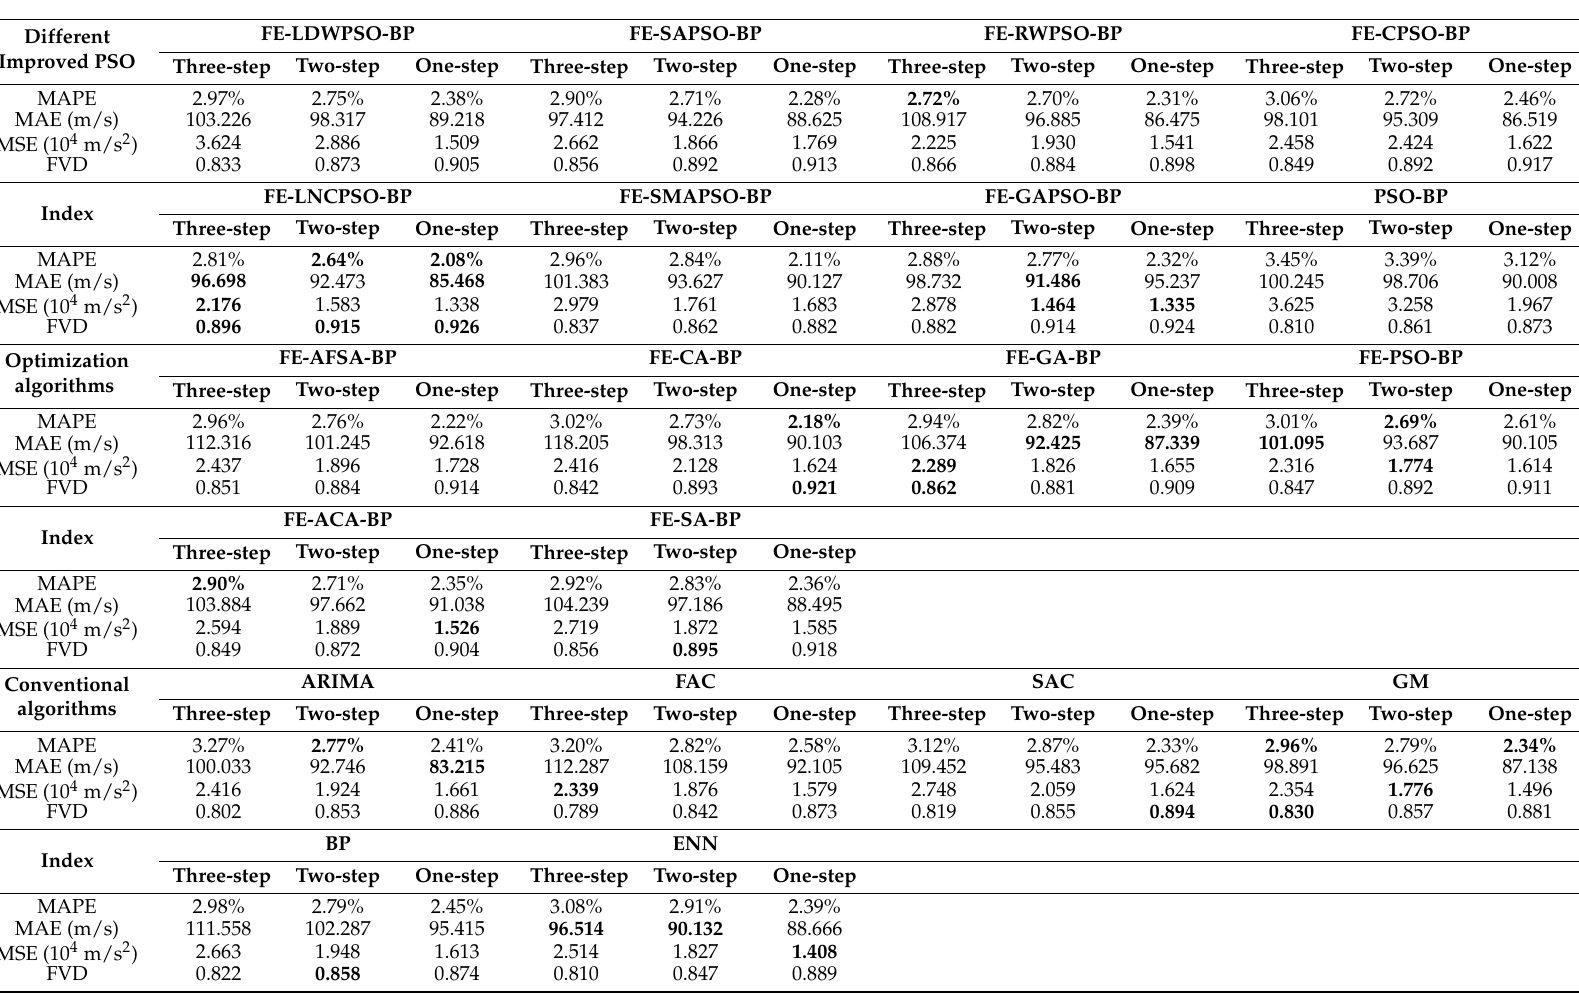
Table 3. Comparison of hybrid models with different optimization algorithms and conventional models for electrical load time